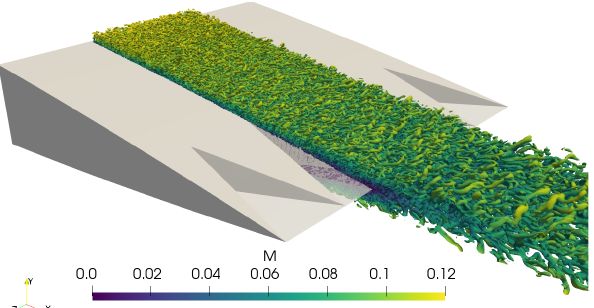
Figure 4. Visualization of vortical structures by the instantaneous isosurfaces of the Q-criterion colour coded by the Mach number for the flow around the poro-serrated